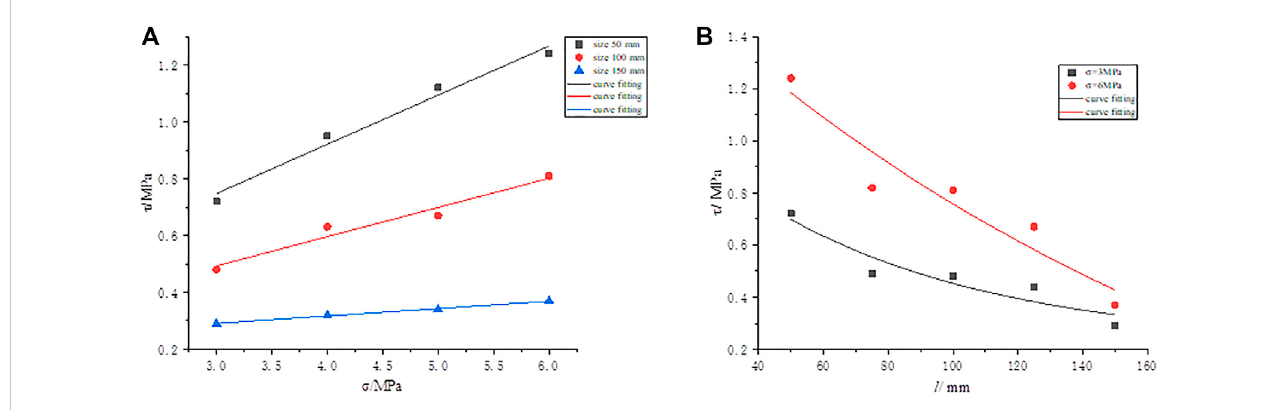
FIGURE 10 Fitting curves. (A) SSSP and normal stress. (B) SSSP and size.